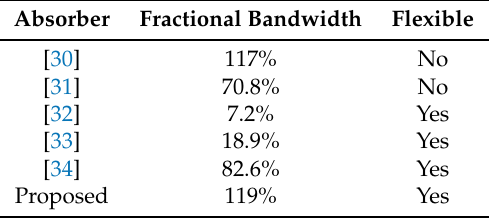
Table 1. Comparison With Previous Absorbers. Fractional bandwidth = 2 ∗ ( f H − f L ) / ( f H + f L ) ∗